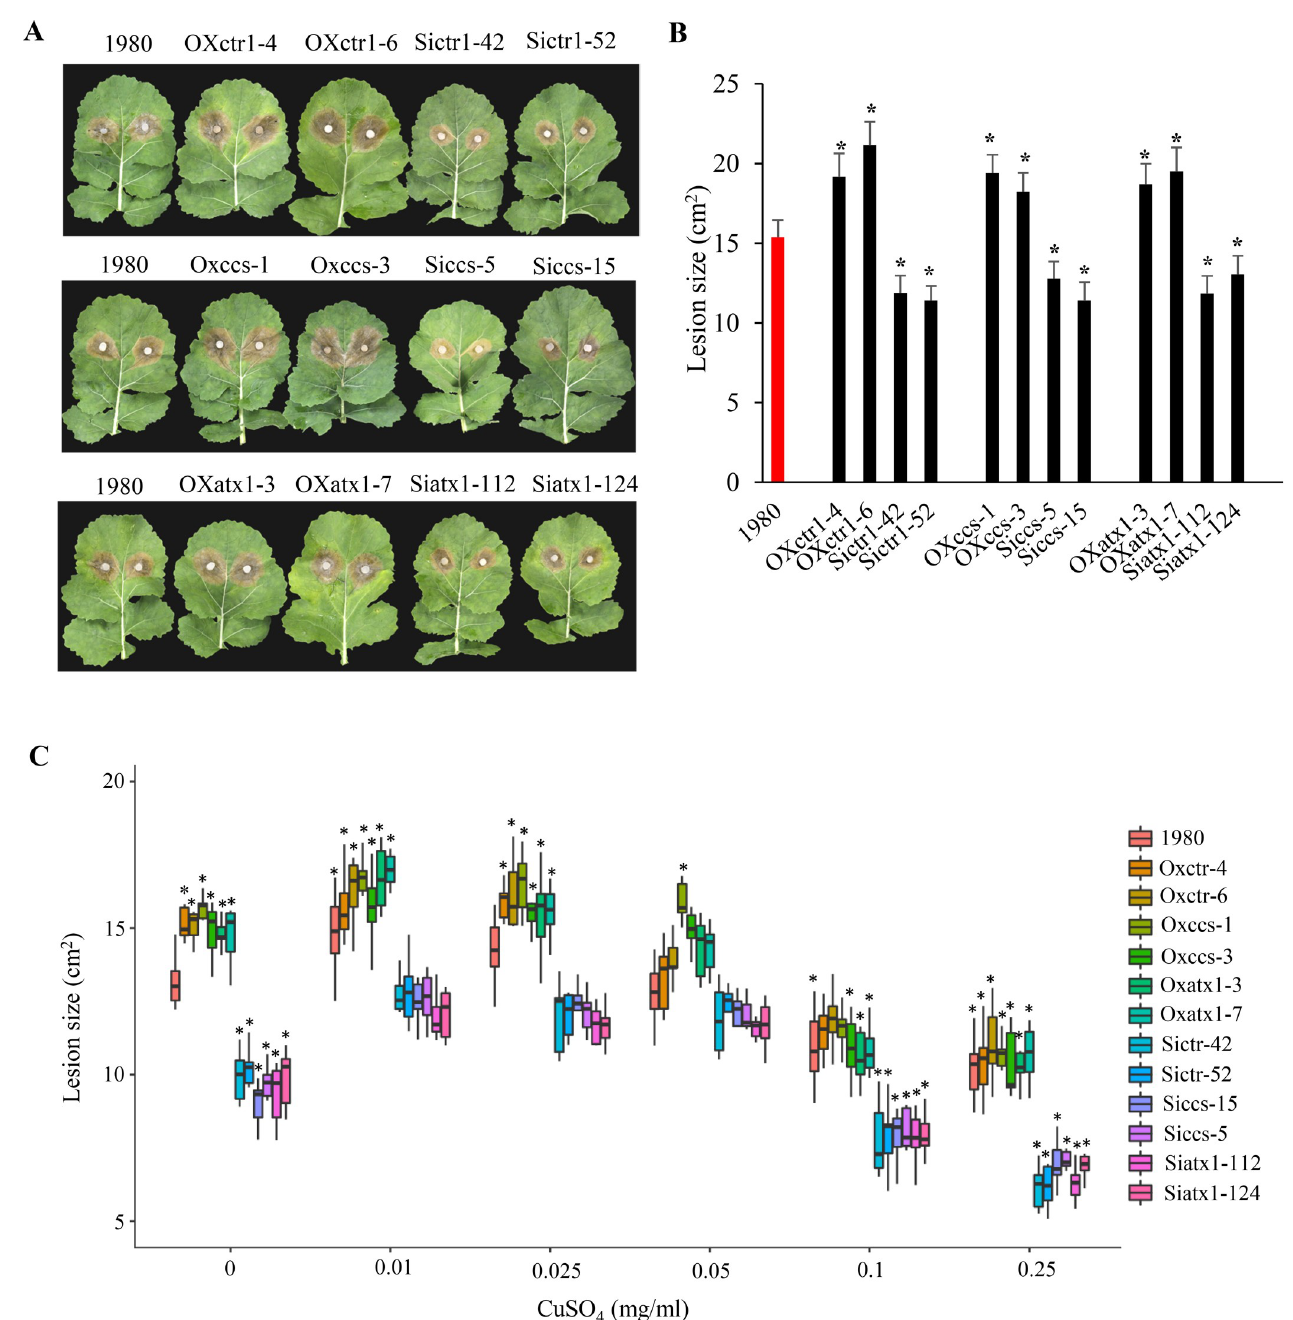
Fig 4. Trace copper restores the virulence of silenced strains of S . sclerotiorum . (A) Disease symptoms of B . napus cv. Zhongshuang 11 leaves at 48 hpi with S . sclerotiorum wild-type strain 1980, overexpression strains (OX) and silenced strains (Si) for genes involved in ‘copper ion transport/import’. One representative replicate from the five experiments is shown. Five leaves were analyzed for each strain in each experiment. (B) Quantitation of lesion sizes at 48 hpi in (A). � : represents significant difference from wild-type strain at 0.05 level (Student’s t -test). (C) Comparison of the lesion sizes on B . napus cv. Zhongshuang 11 leaves produced by wild-type strain, silenced and overexpression strains supplemented with low- and high-concentration of CuSO 4 solutions at 48 hpi. Error bars indicate standard deviation of five independent replicates with five leaves for every sample in one replicate. � : represents significant difference from wild-type strain 1980 which sprayed with ddH 2 O (0 mg/L CuSO 4 solutions) at 0.05 level (Student’s t -test).